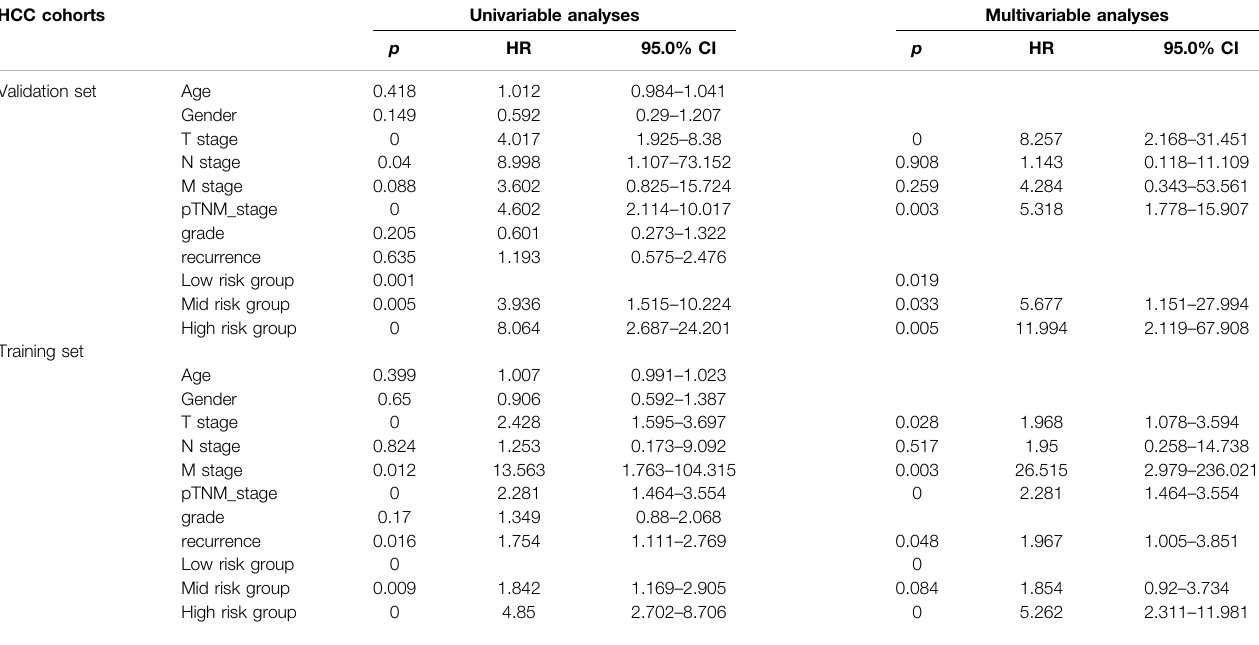
TABLE 3 | Univariate and multivariate Cox regression analyses of risk factors associated with overall survival. HCC cohorts